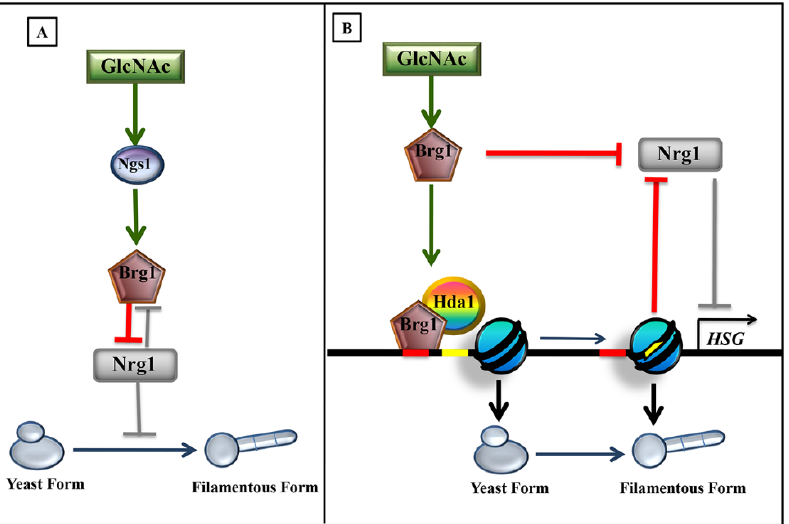
Figure 4. Regulation of N-acetylglucosamine (GlcNAc) induced filamentation occurs in two modes. ( A ) Upon GlcNAc binding/sensing, the activated GlcNAc sensor (Ngs1) upregulates/activates BRG1 through its histone acetylase activity (37). The accumulated Brg1 down regulates NRG1 repressor, and thereby induces Hyphal Specific Gene (HSG) expression to promote hyphal transition. This mechanism occurs in log phase cells at 37 ◦ C under conditions without fresh-medium inoculation [14]. ( B ) Under inoculation conditions in presence of GlcNAc or serum, etc., the hyphal maintenance occurs through activation of BRG1 . Brg1 down regulates NRG1 expression and also causes nucleosome repositioning at Hyphal Specific Gene (HSG) promoters by interacting with histone deacetylase Hda1 to inhibit Nrg1 binding at regulatory sites [46]. The active relationship is represented with green and red lines, whereas inactive relationship is represented with grey lines.